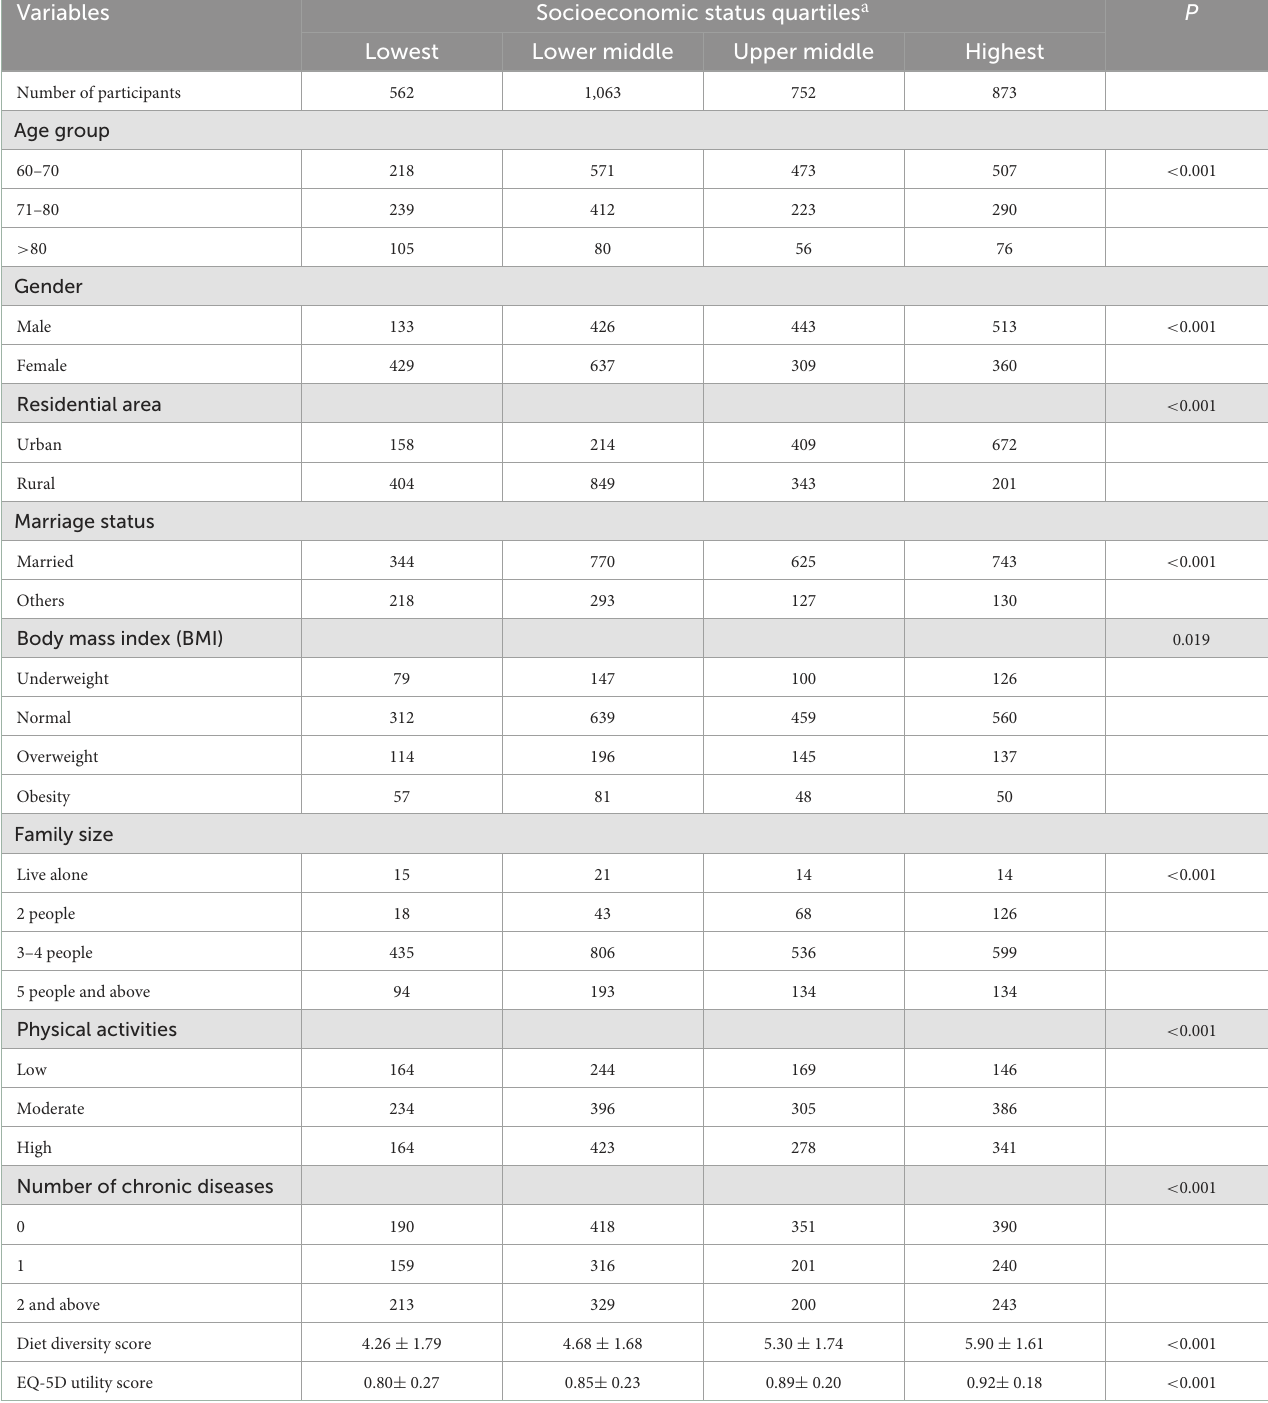
TABLE 1 Characteristics of the participants across socioeconomic status quartiles ( N =